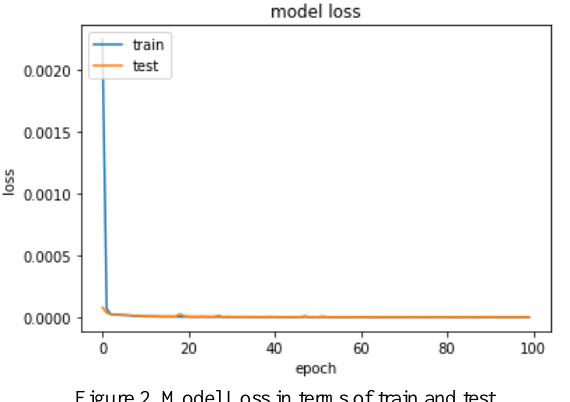
Figure 2. Model Loss in terms of train and test